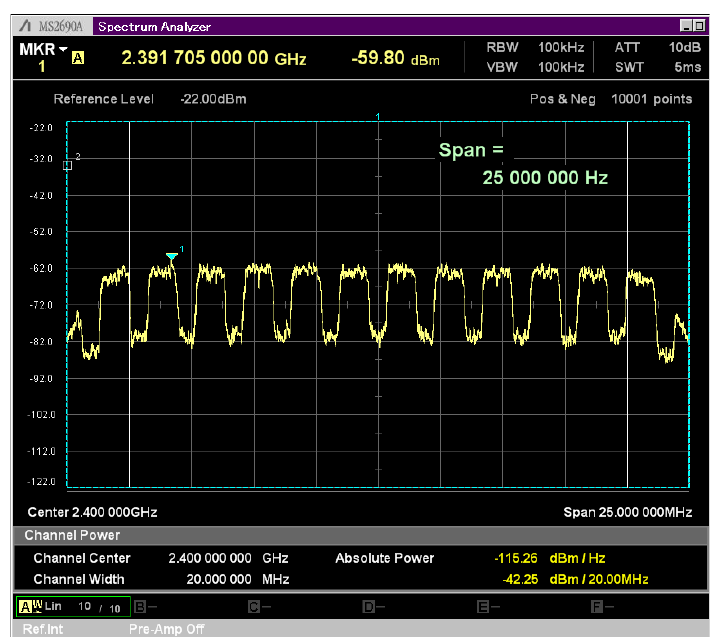
Figure 17. Spectrum of 12 vPHYs concurrently transmitting at a center frequency of 2.4 GHz.